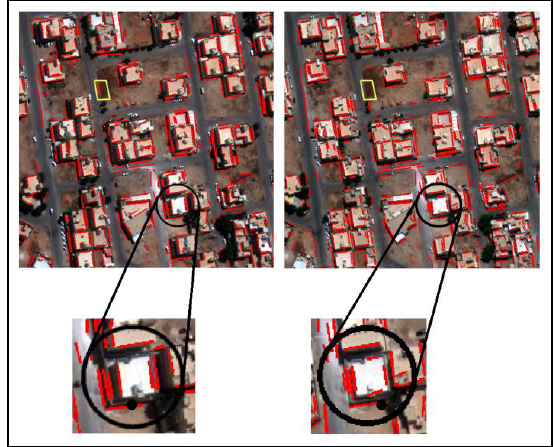
Figure 8. Matching of straight lines in epipolar images; the yellow parallelograms show how the epipolar constrain reduces matching candidates; the black circles show ambiguous cases (for further explanation see